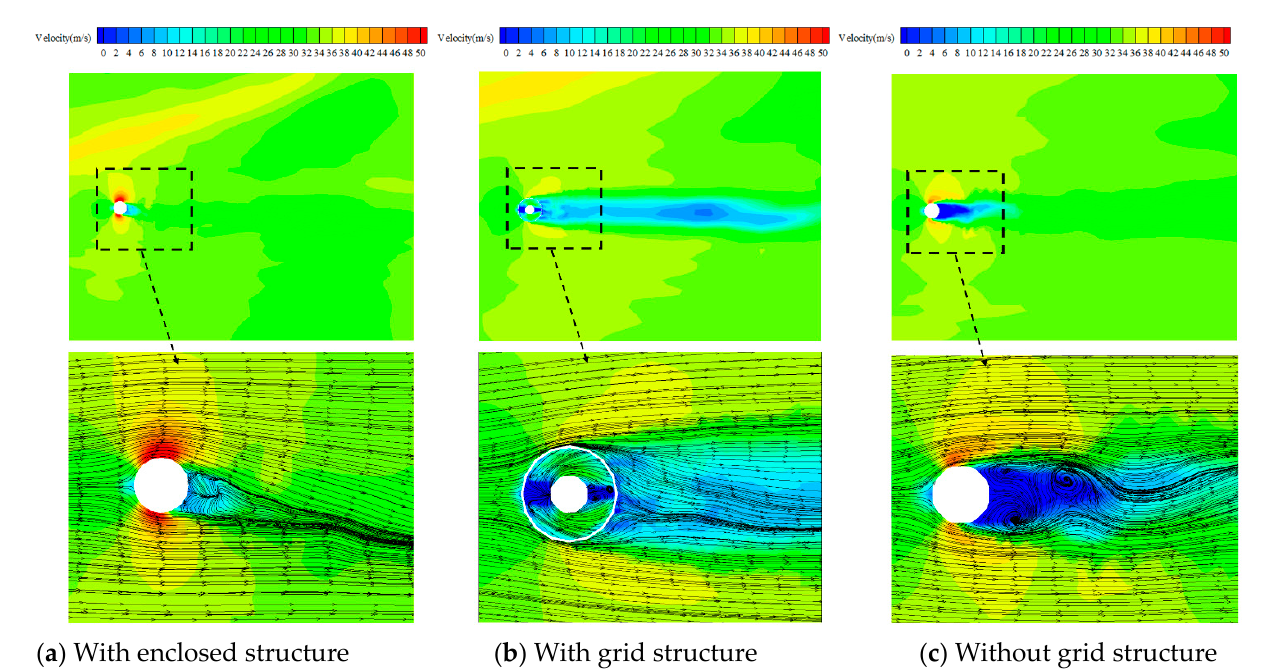
Figure 20. Instantaneous wind speed contours and streamlines of the three models at 20 s in the plane of Y = 200 m.